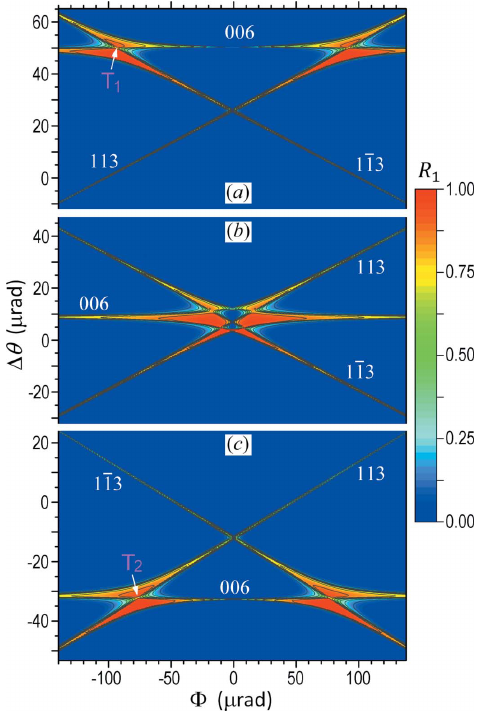
Figure 2 Computed 2D ‘rocking curve’ of the 000 = 006 = 113 = 1 (cid:3) 113 4BD setup in Fig. 1 showing the reflectivity R 1 of the main reflection g 1 = 006 as a function of the incidence angle ( (cid:2) , (cid:4) (cid:2) ) and the photon energy E . The indices of each line (diffraction cone) indicate the corresponding Bragg reflection. (cid:5) -polarization, i.e. the electric field of the incident wave, is parallel to [010] in Fig. 1( a ). Semi-infinite Si crystal. (cid:4) (cid:2) = 0 always corresponds to (cid:2) 4B = 40.6013 (cid:3) . ( a ) E = E 4B (cid:4) 0.5 eV. ( b ) E = E 4B . ( c ) E = E 4B + 0.5